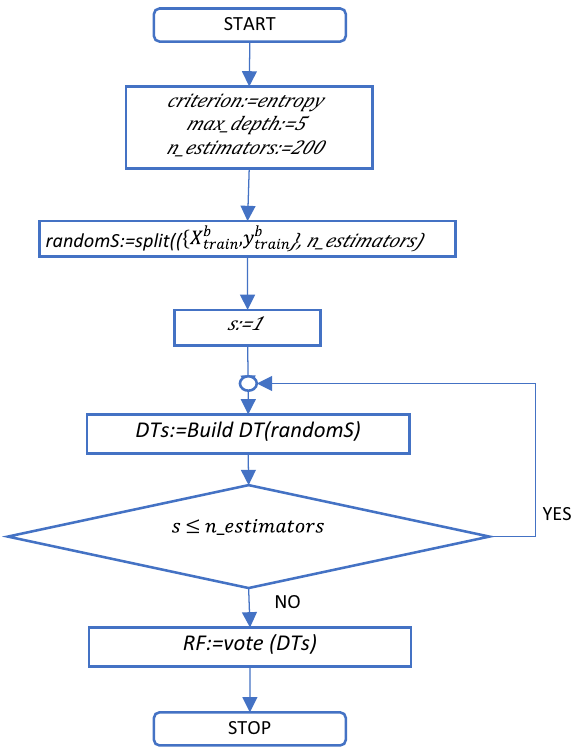
Figure 8. RF training process.